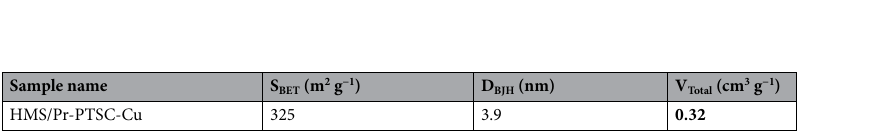
Table 2. Textural properties of HMS/Pr-PTSC-Cu obtained by nitrogen adsorption/desorption